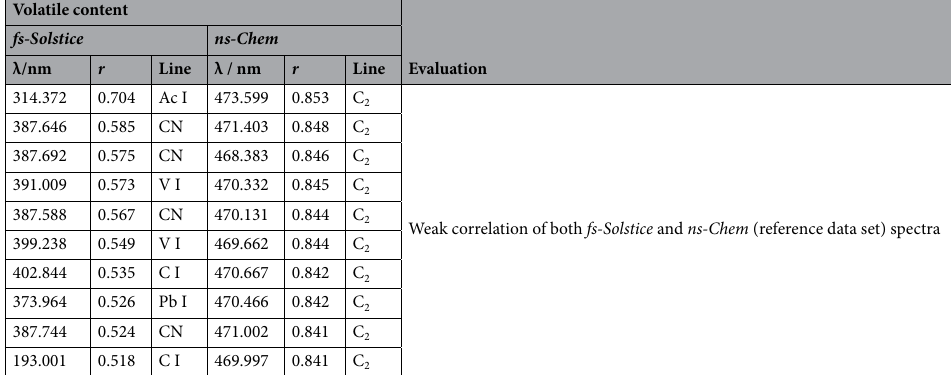
Table 3. Evaluation of fs-Solstice spectra correlation to volatile content in coal samples.